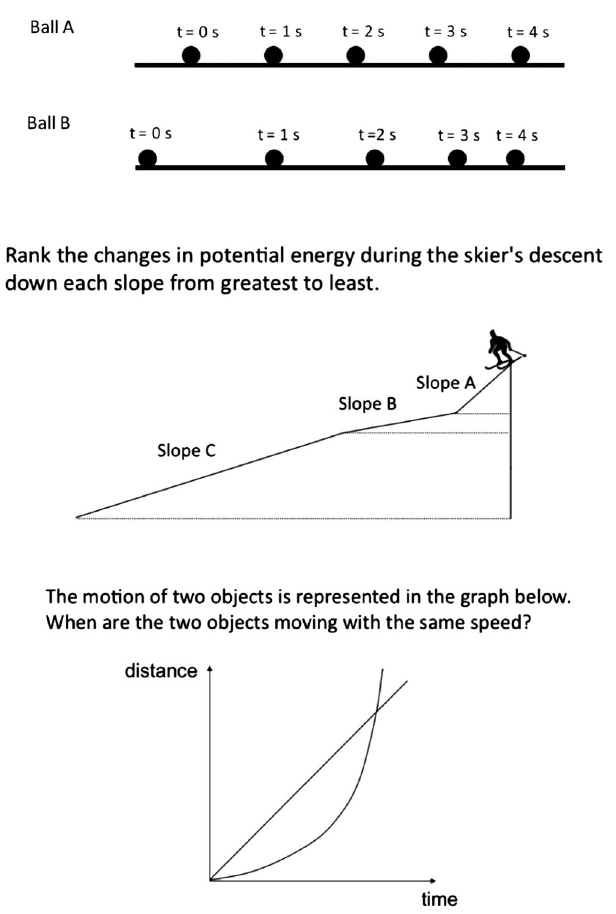
FIG. 1. Four ‘‘initial’’ problems taken from Madsen et al. (Ref. [15]) and used in the current study. Shown from top to bottom are the roller coaster, ball, Skier, and graph